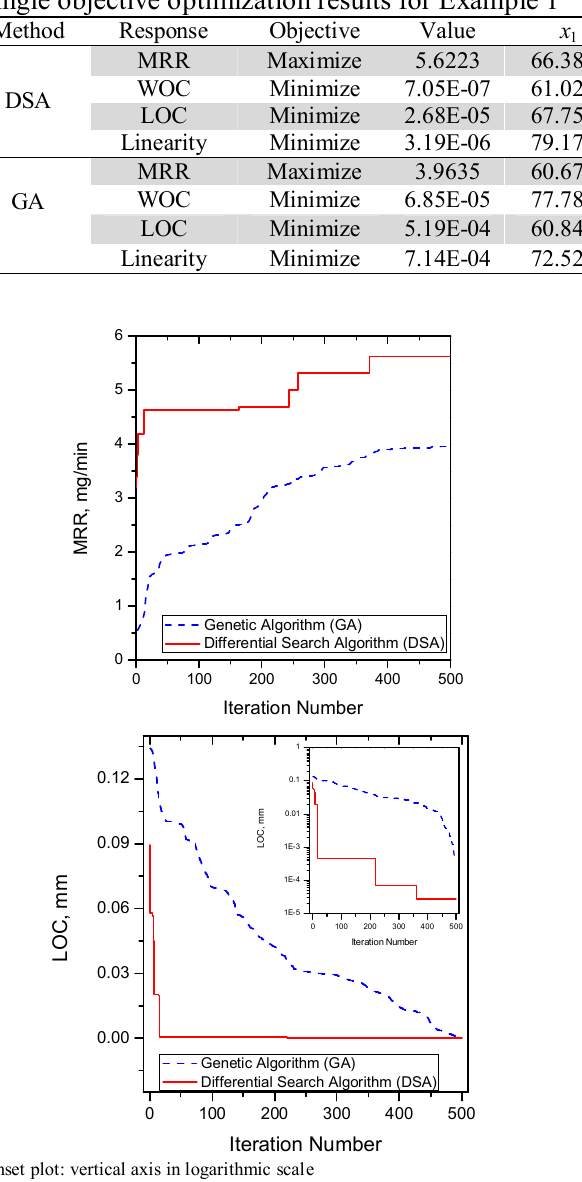
Fig. 1. Convergence diagrams of DSA and GA for Example